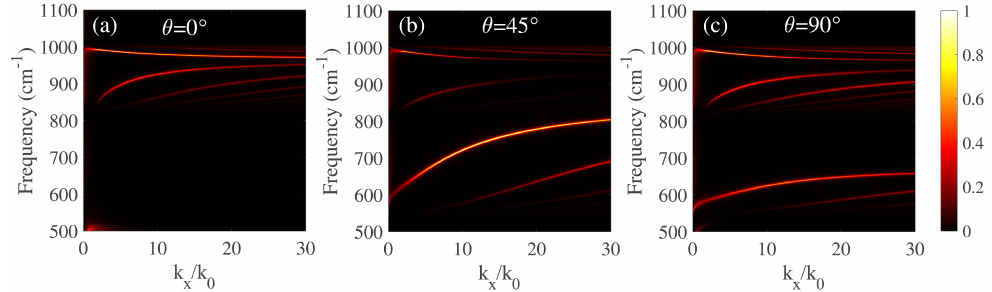
Figure 3. Dispersion curves under different twist angles. ( a ) θ = 0 ◦ , ( b ) θ = 45 ◦ , and ( c ) θ = 90 ◦ . There is no external magnetic field in this case.